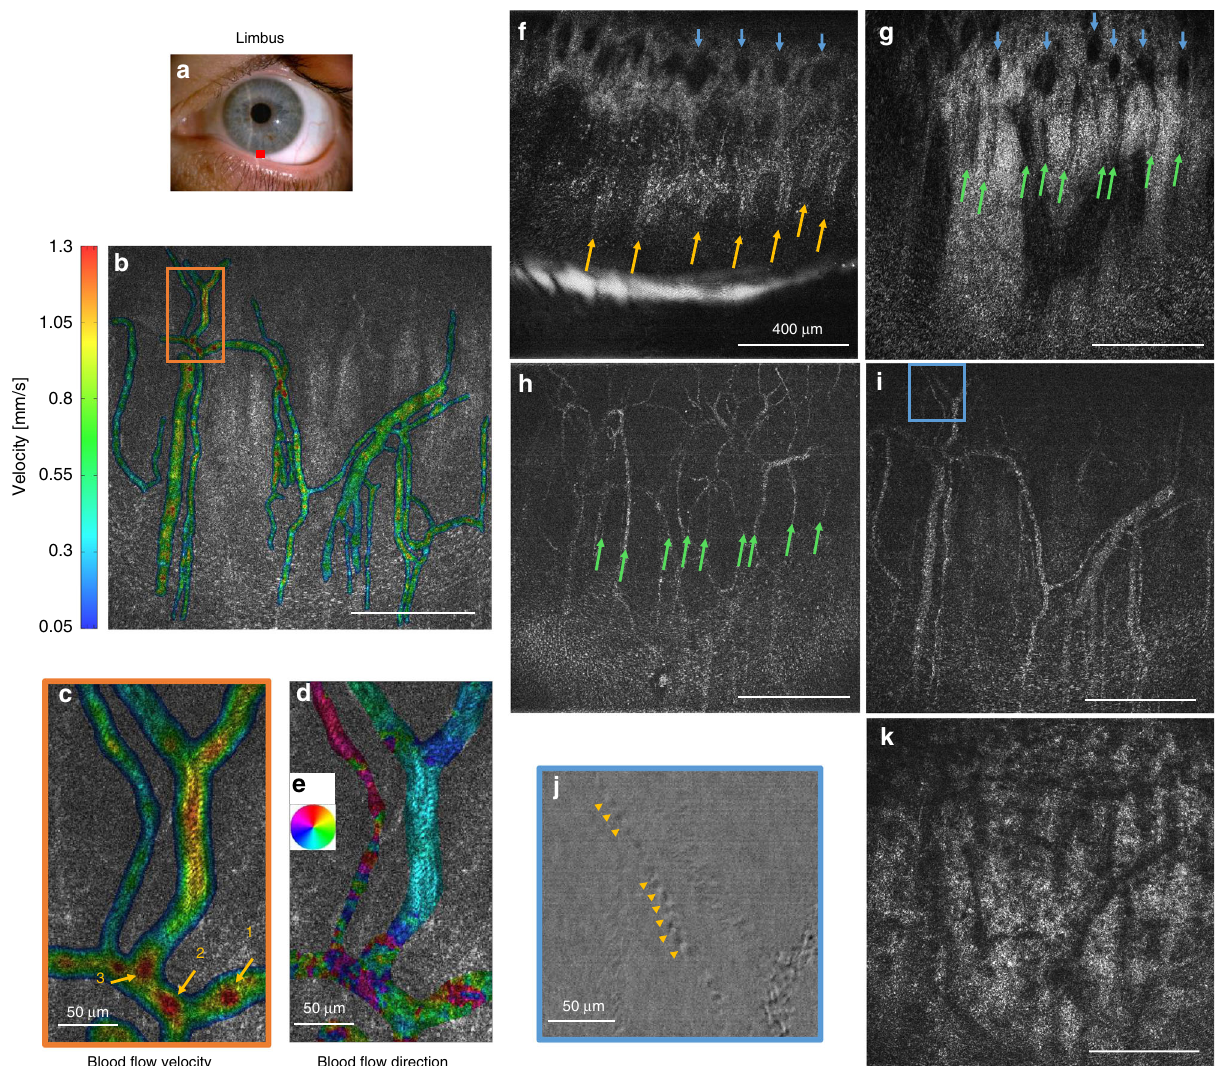
Fig. 8 Common-path FF/SD OCT imaging and angiography of in vivo human limbus. a Slit-lamp macro photo obtained from one of the subjects. Red square depicts location, where FFOCT images were acquired. b , c Blood fl ow velocity map, retrieved from the rapidly acquired movie at 275 images/s (Supplementary Movie 12), together with a zoomed image. The lowest speeds were measured close to vessel walls and highest speeds in the middle of the vessels, in junction points (point 2 and point 1 (with merging vessel coming to point 1 visible only in the movie)) and also, as artifacts, if vessels overlaid each other (point 3). d Blood fl ow orientation map retrieved from the movie. Each color corresponds to a certain direction of blood fl ow, according to the colormap e . f – k Single frame FFOCT images of consecutive depths in limbus. Yellow arrows — palisades, green arrows — thin vessels hosted within palisades, blue arrows — perpendicular vessel network thought to be connected with horizontal vessels. Underneath, thicker vessels and scattering stroma- sclera medium with vessel shadows were seen. j Zoomed view on thin vessel in i . Image is obtained by subtracting the two camera shots. Contrast is reduced (see Methods), but is more intuitive for resolving and following individual blood cells (yellow arrows) (Supplementary Movie 12). Unlabeled scale bars are 400 µ m. Experiments were reproduced several times in each of the three healthy